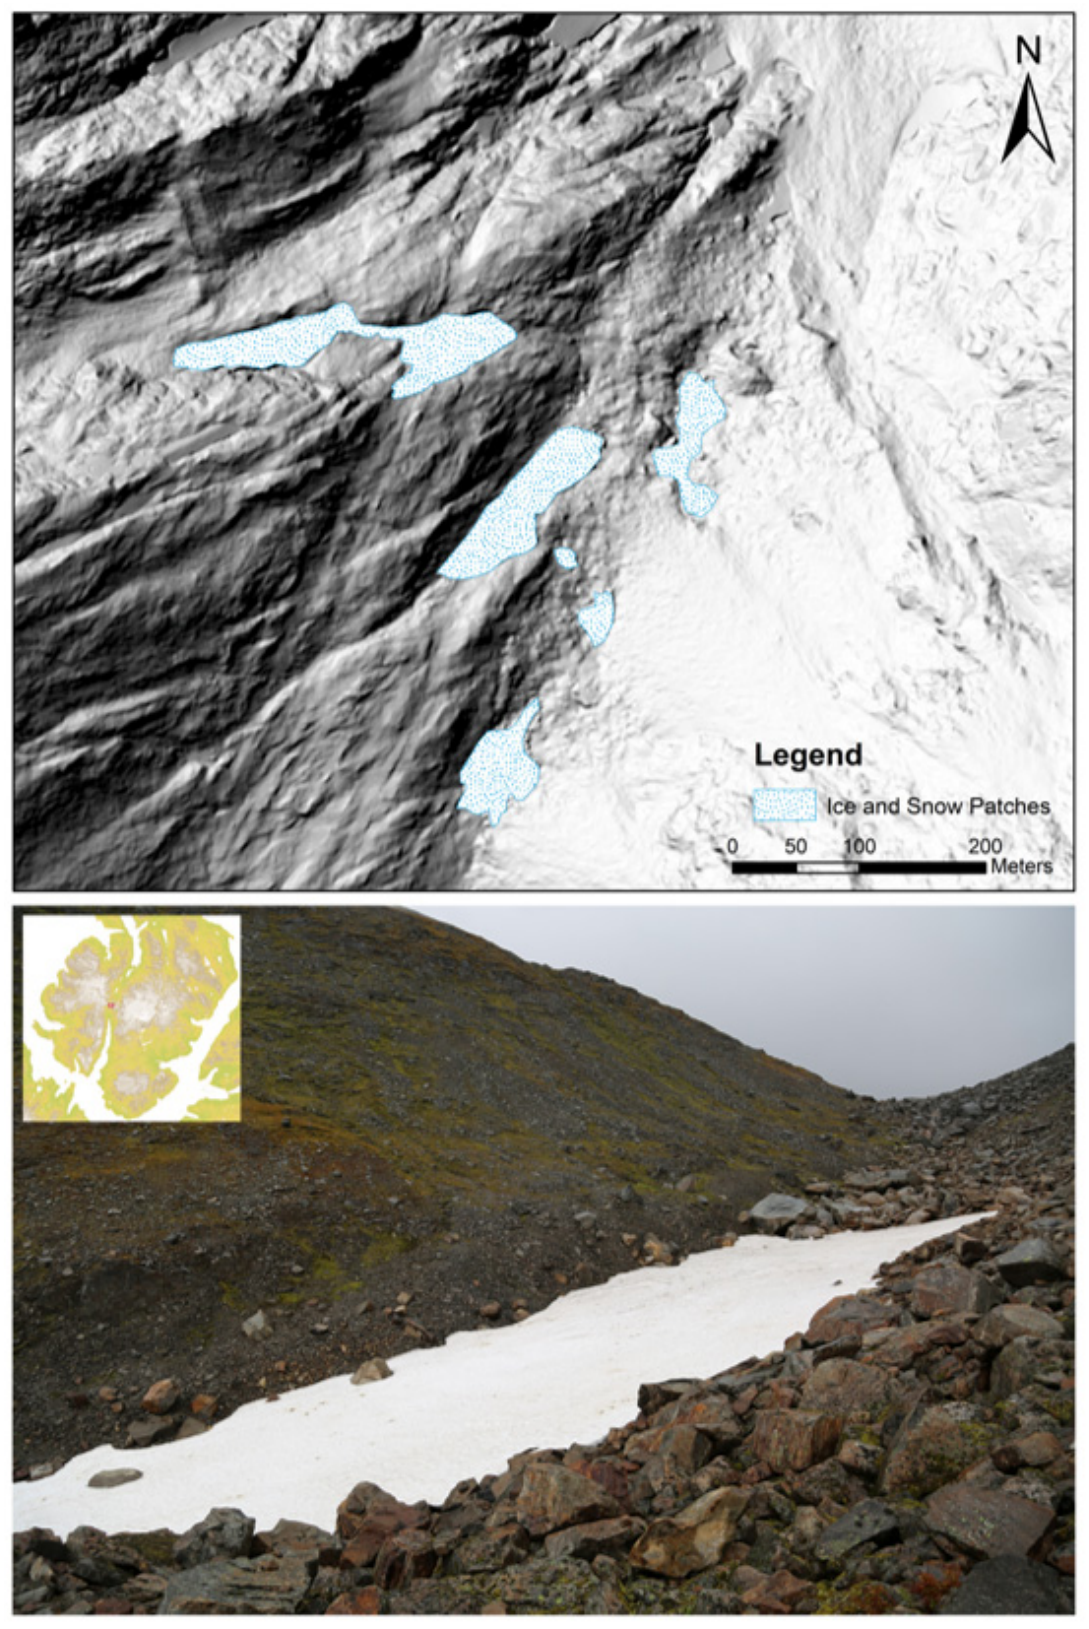
Figure 5. Ice and snow patches on the Seiland mountain pass. The former ice patches have completely melted away exposing a boulder field. WGS 84/UTM Zone 34N. On the eastern plateau, the terrain was significantly more rugged than anticipated. Large boulder fields which were once covered in snow and ice are now an obstacle for